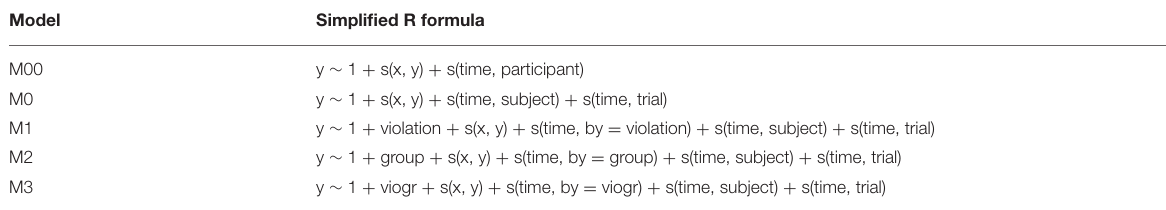
TABLE 9 | Model space for pupil dilation in the pupillometry task.